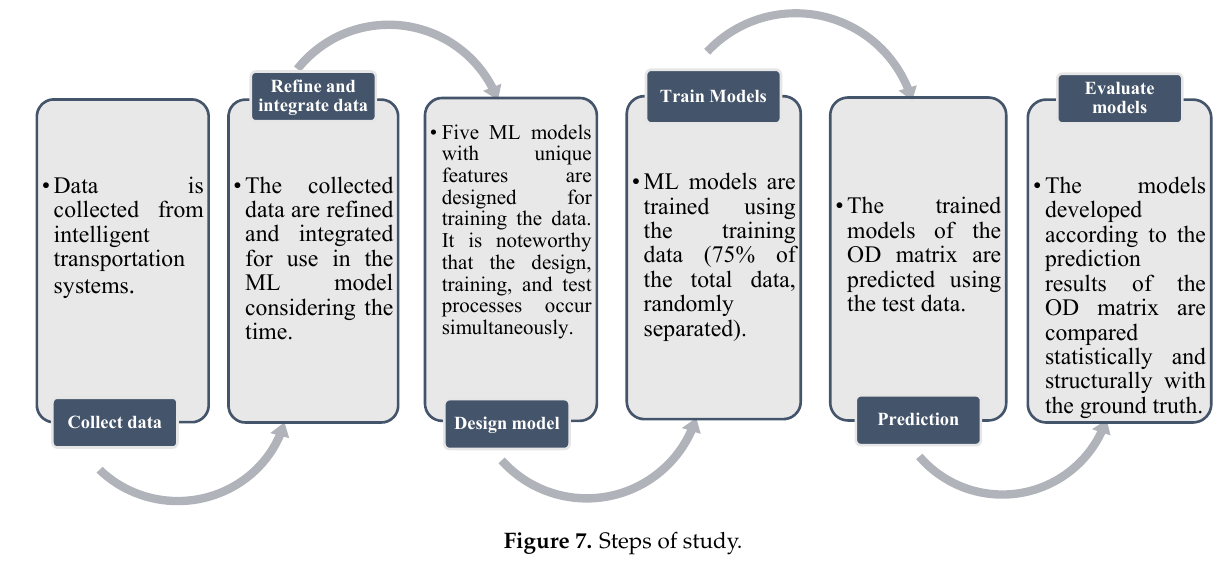
Figure 7. Steps of Figure 7. Steps of study.